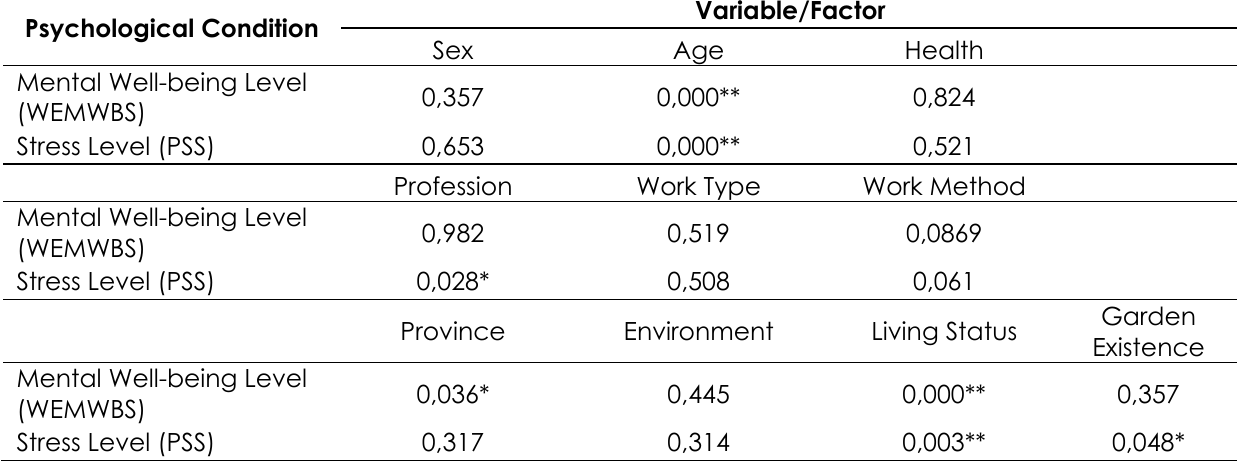
Table 4. The result of the p-value correlation test between psychological condition and sociodemographic factors.